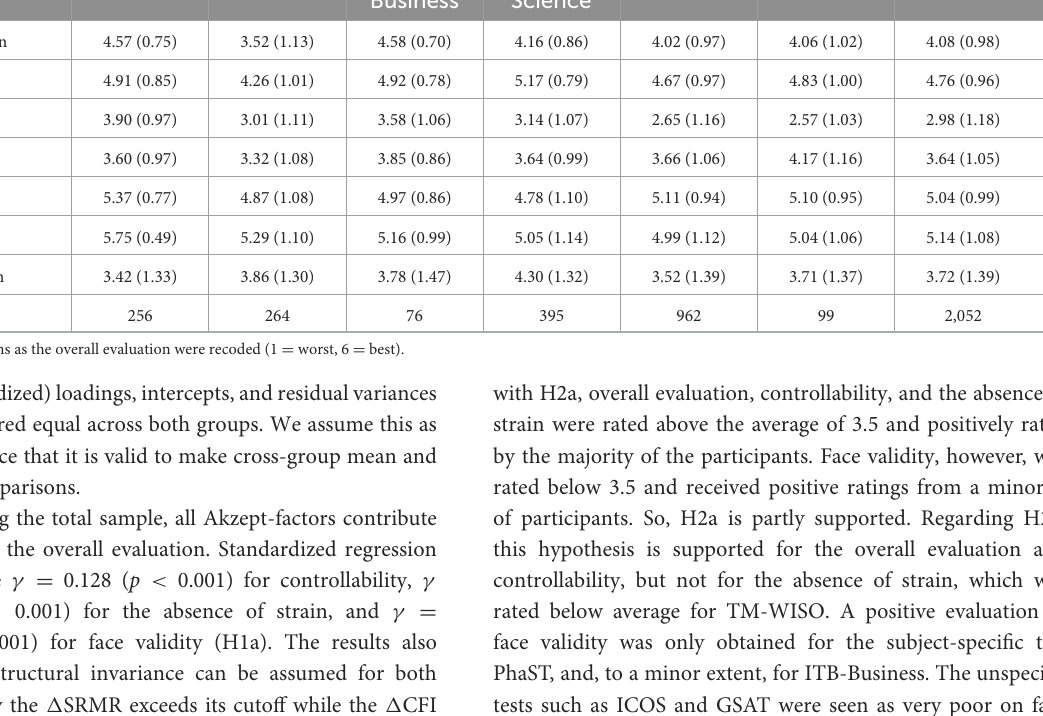
TABLE 4 Average ratings by test: mean values and (in parentheses) standard deviations.